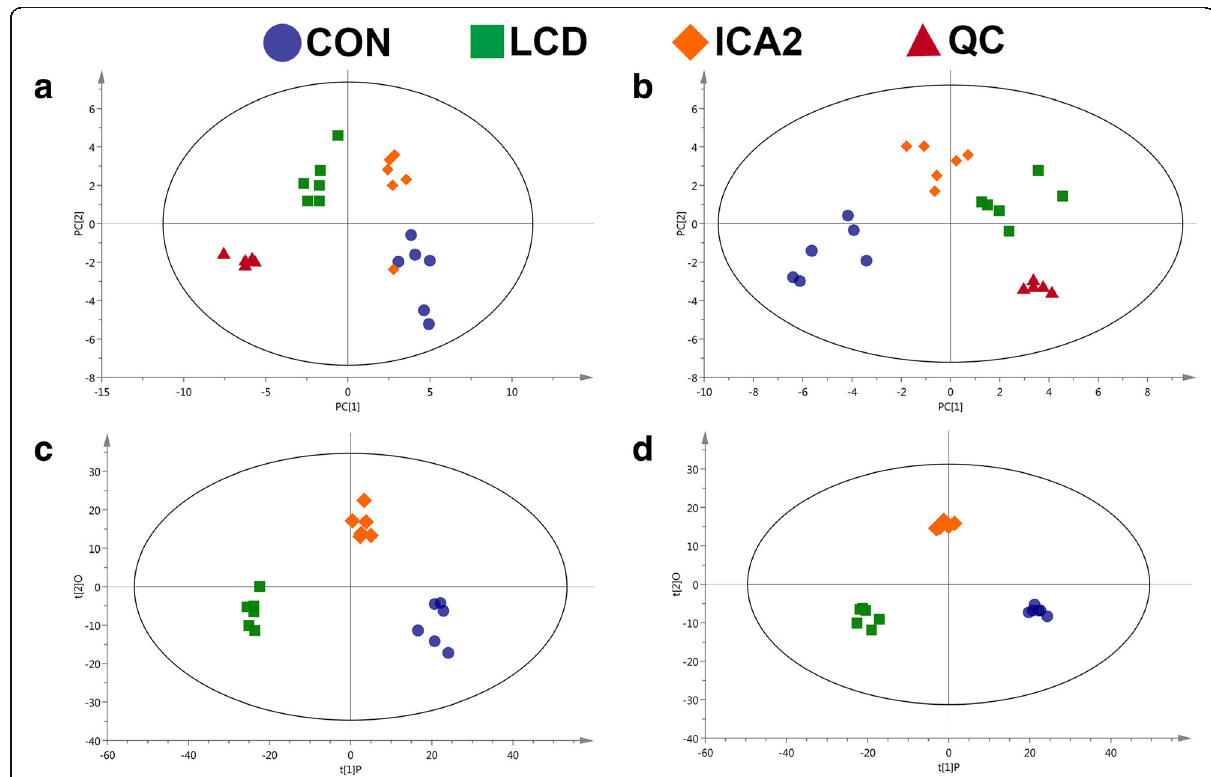
Fig. 6 Quality control test and multivariate statistical analysis of serum metabolomics test. a PCA score plots in positive ion mode. b PCA score plots in negative ion mode. c OPLS-DA score plots in negative ion mode. d OPLS-DA score plots in negative ion mode. ICA, icariin. QC, quality control. CON, basal diet. LCD, low calcium diet. ICA1, low calcium diet supplied with 0.5 g/kg ICA. ICA2, low calcium diet supplied with 2.0 g/kg